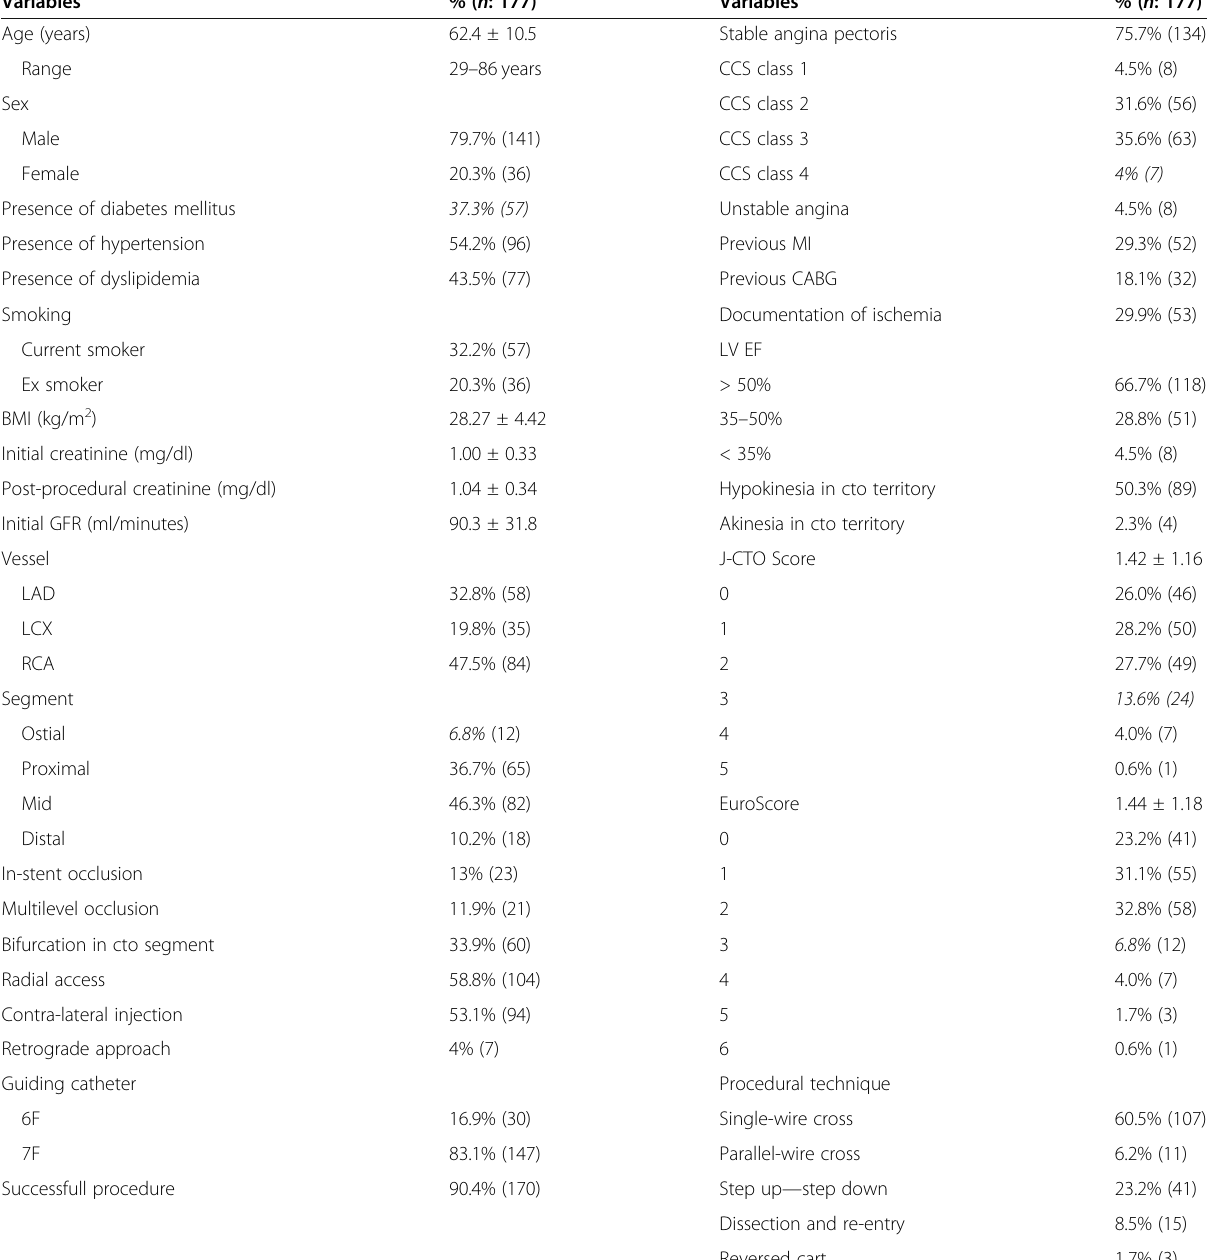
Table 1 Baseline demographic characteristics, clinical features, and laboratory results of the patients. Angiographic, technical, and procedural features of chronic total occlusion lesions were also summarized in the lower part of the table